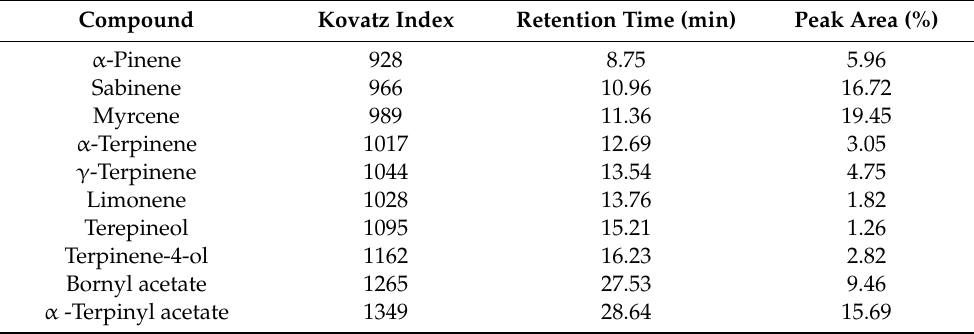
Table 3. Main components of essential oil from Chamaecyparis obtusa